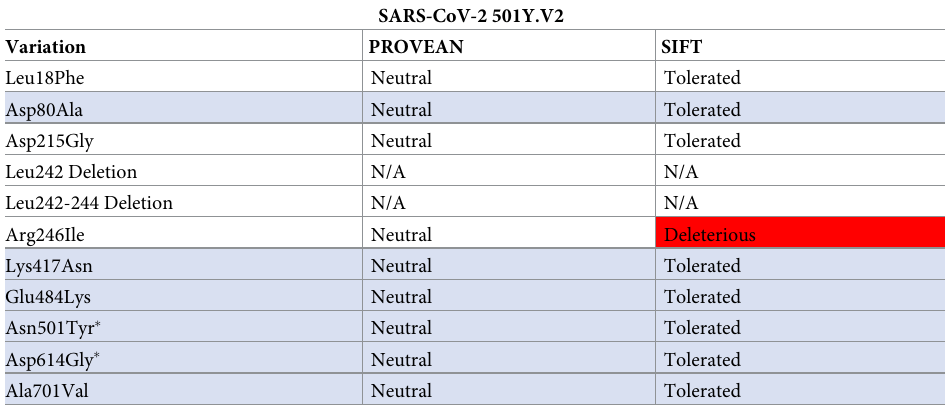
Table 2. Predicted biological impact of mutations in the SARS-CoV-2 501Y.V2 spike protein.